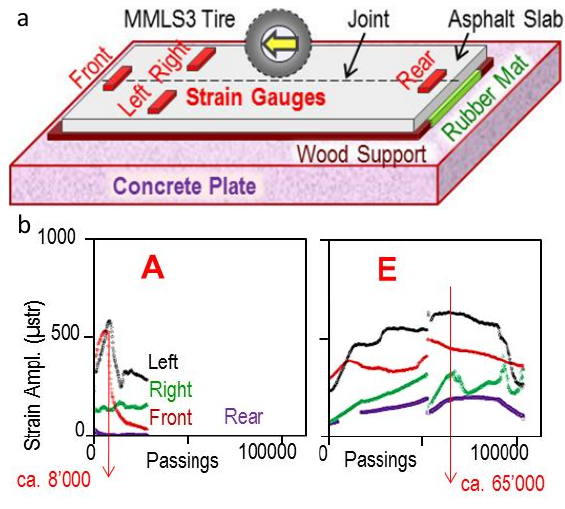
Figure 8. a) Setup for MMLS testing of construction joints; b) strain amplitudes at different locations vs. passings for joint design A